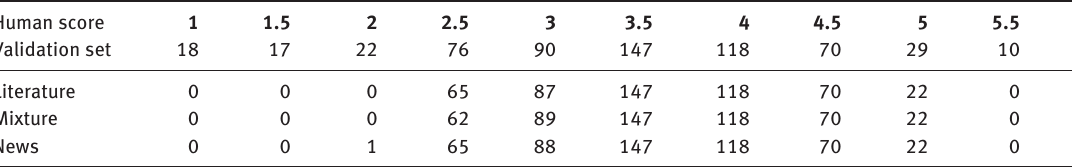
Table 5: Scoring Details of Conventional LSI.